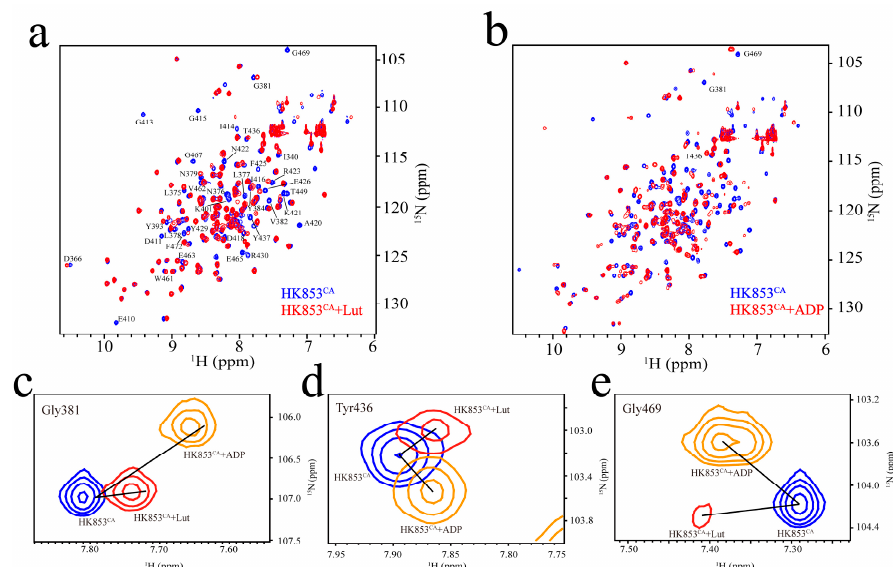
Figure 4. Interactions between HK853 CA and ADP/Lut. ( a ) The spectrum in blue shows the 15 N- 1 H HSQC signals of HK853 CA without Lut, while the Lut containing group is in red (reaction conditions: 20 mM HEPES, 50 mM KCl, 10 mM MgCl 2 , 0.4 mM HK853 CA , and 0.8 mM Lut with 10% D 2 O, pH 7.0); ( b ) the spectrum in blue shows the 15 N- 1 H HSQC signals of HK853 CA without ADP, while the ADP containing group is in red (reaction conditions: 20 mM HEPES, 50 mM KCl, 10 mM MgCl 2 , 0.4 mM HK853 CA , and 0.8 mM ATP with 10% D 2 O, pH 7.0); ( c ) the superimposed spectra of peak Gly381. Peaks from spectrum HK853 CA , HK853 CA + ADP and HK853 CA + Lut were respectively exhibited in blue, orange, and red; ( d ) the superimposed spectra of peak Tyr436, with the same color code as ( c ); ( e ) the superimposed spectra of peak Gly469, with the same color code as ( c ).